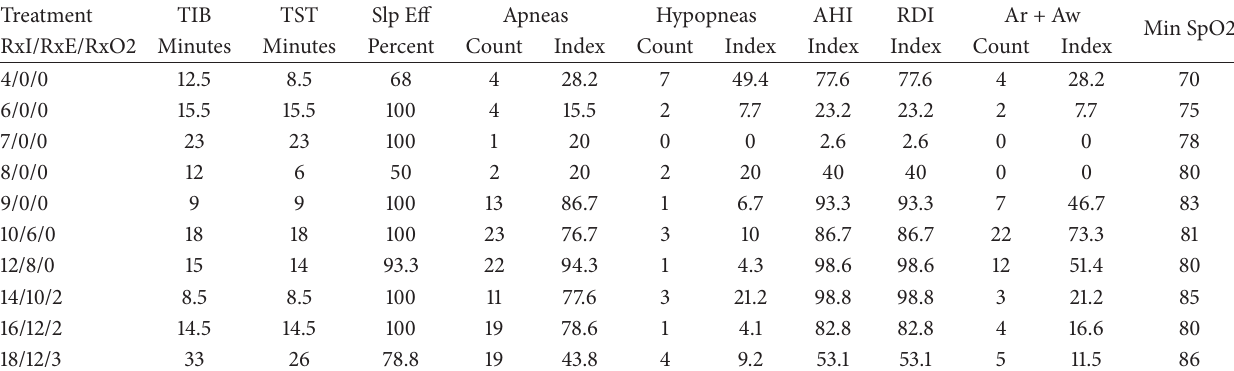
Table 7: Treatment parameters and